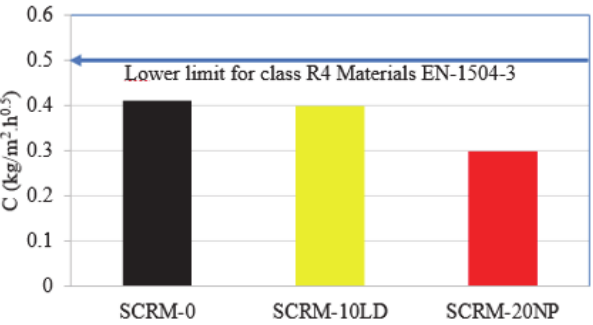
Figure 9: Evolution of water absorption after 24 hours for